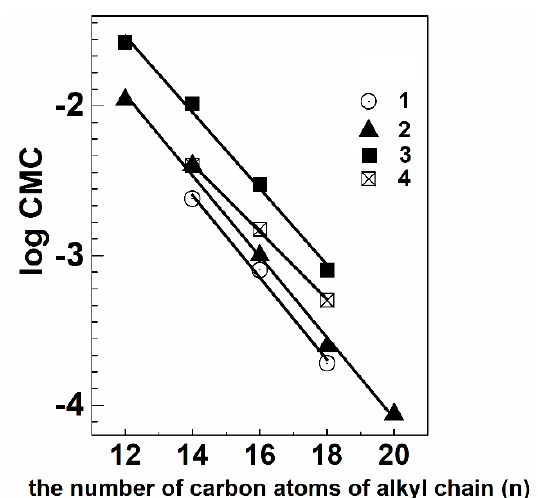
Figure 3. The effect critical micelle concentration (CMC) on chain length (n) and amount of charge of cationic surfactants based on DABCO and quinuclidine, quinuclidine (Q-Nuc-n) (1), mono-DABCO-n (2), di-DABCO-Et-n (3), and tetra n-DABCO-s-DABCO-n (4) 25 °C.